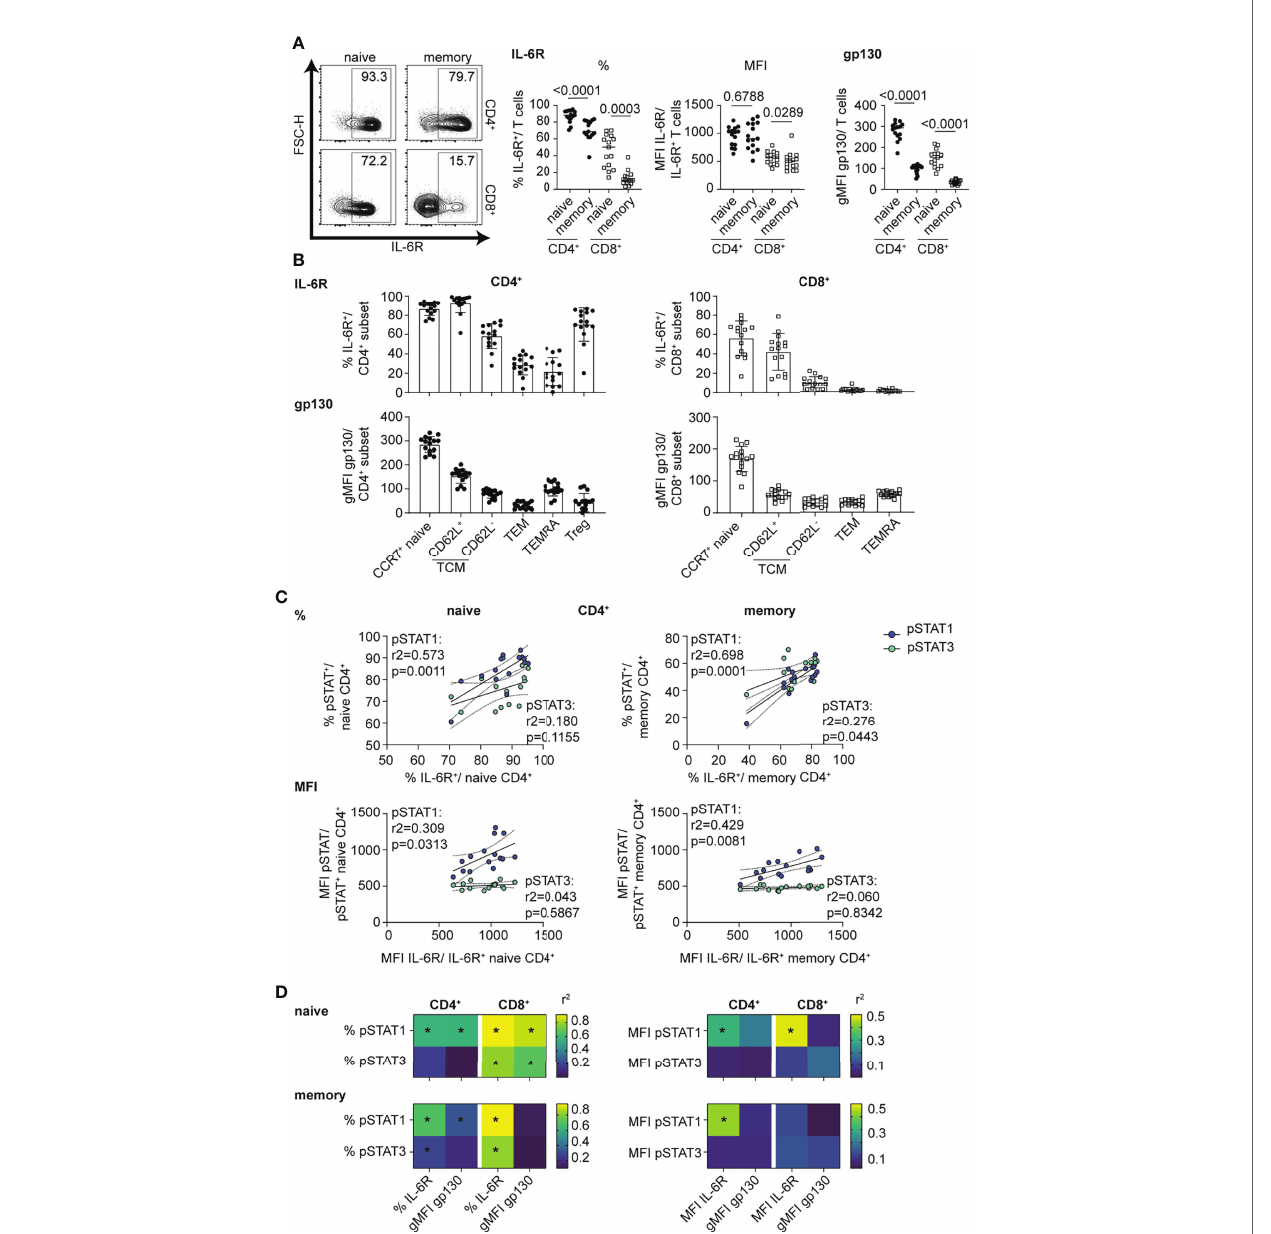
FIGURE 2 | mbIL-6R levels direct strength of pSTAT1 signaling response in CD4 + and CD8 + T cell subsets. (A-D) CD3-enriched T cells were left unstimulated or (C, D) stimulated with IL-6 (20 ng/mL) for 30 min or and mbIL-6R and gp130 levels or the pSTAT1 and pSTAT3 response were determined by fl ow cytometry. (A) Representative fl ow plot of mbIL-6R expression and frequencies and MFI of gated mbIL-6R + cells (middle) or gMFI expression levels of gp130 (right) among naïve or memory CD4 + (non-Treg) and CD8 + T cells or (B) CD4 + and CD8 + T cell subsets in the context of T cell maturation. (C) Simple linear regression analysis of expression levels as frequencies (%, top) or MFI (bottom) of gated mbIL-6R + and pSTAT1 + or pSTAT3 + cells in naïve or memory CD4 + (non-Treg) T cells. (D) Summary data of simple linear regression analysis of expression levels as frequencies (left) or MFI (right) of gated mbIL-6R + or the gMFI of gp130 and pSTAT1 + or pSTAT3 + cells in naïve or memory CD4 + (non-Treg) and CD8 + T cells. (A) Wilcoxon matched pairs signed rank test. (C, D) Linear regression analysis with Pearson ’ s correlation coef fi cients. n =